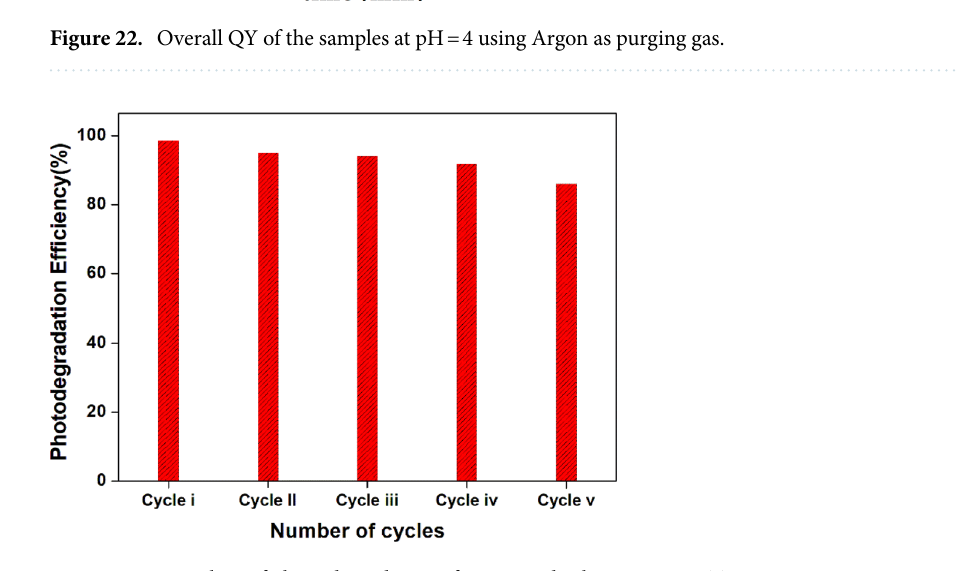
Figure 23. Recycling of photo degradation of Congo red solution using